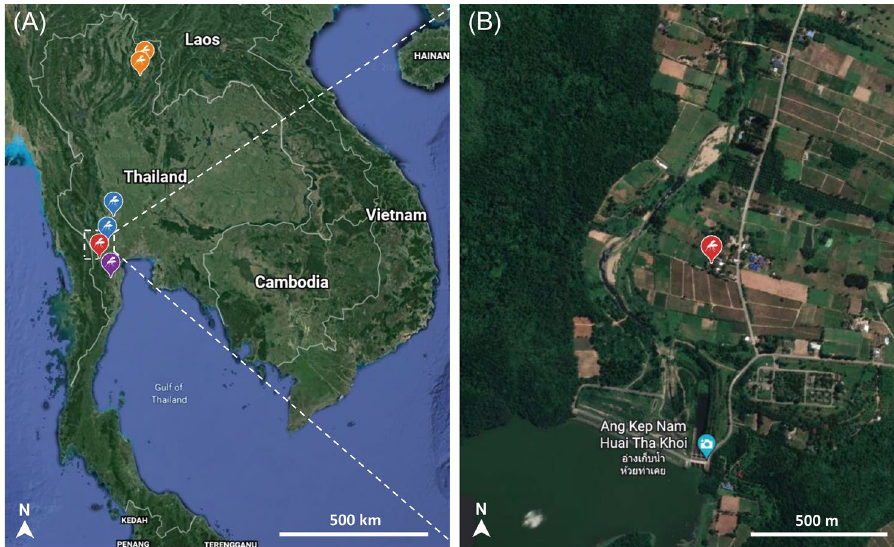
Figure 5. ( A ) Map illustrating the sampling sites in four provinces of Thailand. The orange, blue, red, and purple mosquito silhouettes represent sampling sites in Nan, Kanchanaburi, Ratchaburi, and Phetchaburi provinces. ( B ) A magnified satellite view of mosquito and blood sampling sites in Ratchaburi, where P. caprae - positive blood and mosquitoes were found. The images were obtained and modified from Google Earth Pro version 7.3.4.8248 (https:// google- earth- pro. updat estar. com/